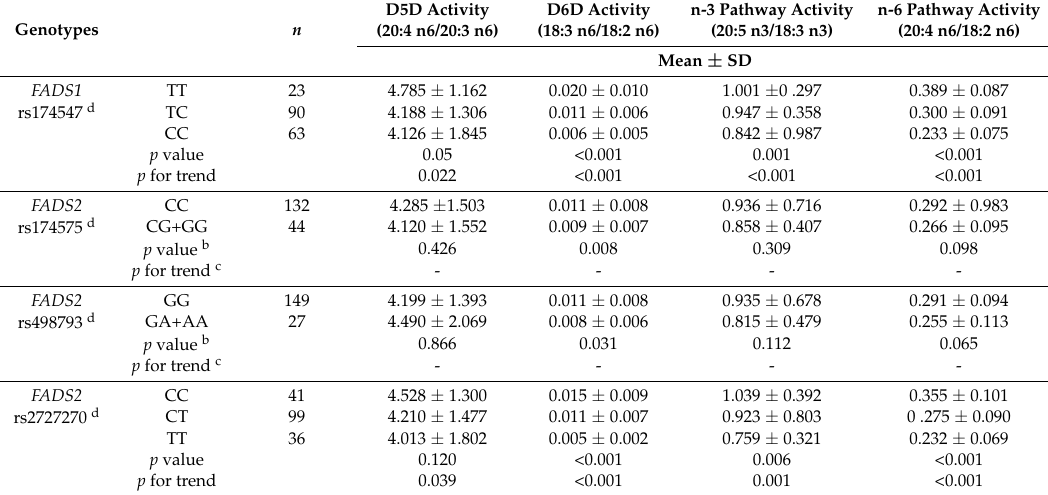
Table 3. The differences of fatty acid desaturase activities among FADS1 and FADS2 genotypes in type 2 diabetes patients ( n = 176) a